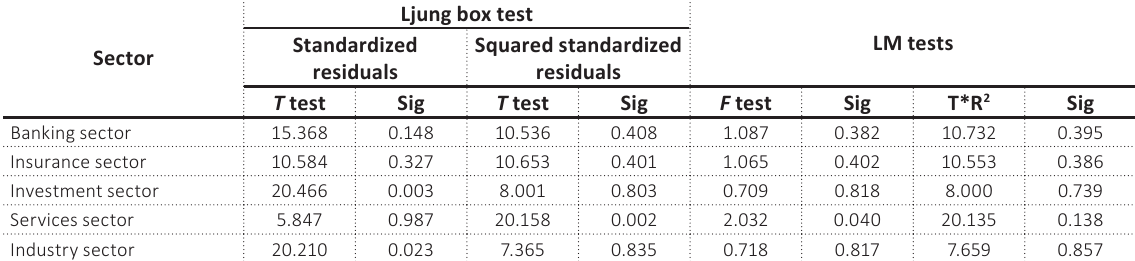
Table 9. Diagnostic